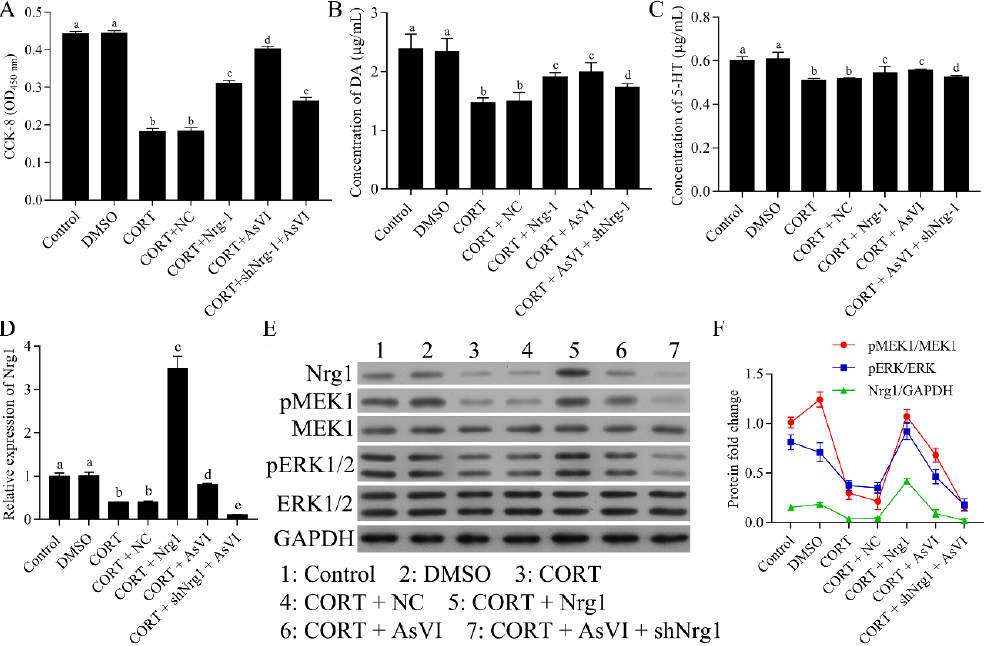
Figure 7. AsVI improved the CORT-induced cellular model of major depression by upregulating the NRG-1-mediated MAPK pathway. PC-12 cells were split up into Control, DMSO, CORT, as well as CORT + AsVI. The CORT model cohort was transfected with pcDNA3.1-NRG-1, and the CORT + AsVI cohort was transfected with shNRG-1. ( A ) The cell viability was established by the CCK-8 assay. ( B ) HPLC analysis was conducted to measure the DA release levels for various therapies in PC12 cells. ( C ) HPLC analysis was conducted to ascertain 5-HT release levels for various therapies in PC12 cells. ( D ) A quantitative real-time PCR method was carried out to identify the expression level of NRG-1 mRNA in different treated PC12 cells. ( E , F ) Western blot for NRG-1, MEK1, p-MEK1, ERK1/2, as well as the p-ERK1/2 protein for different treatments in PC12 cells. All the experiments were conducted thrice. Data are articulated as Mean ± SD. Distinct letters (a, b, c, d) denote significant differences in various cohorts. p < 0.05.